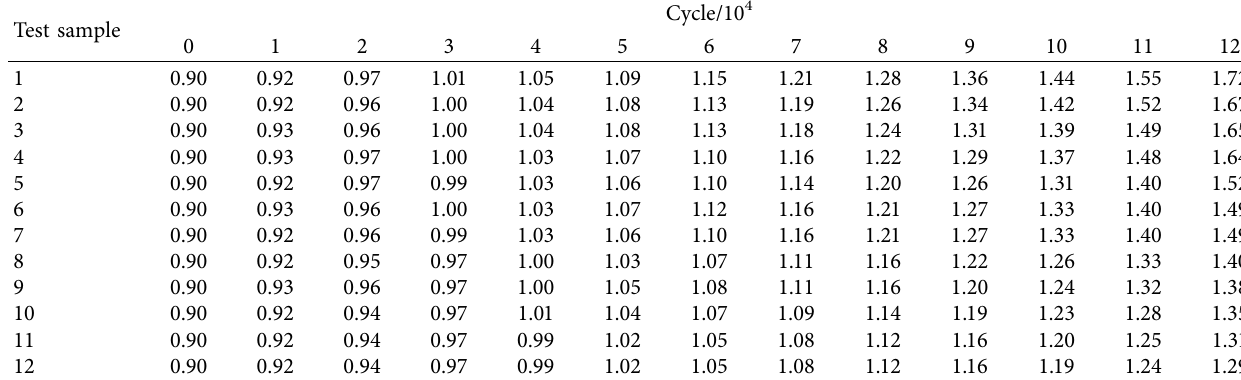
Table 1: Fatigue crack growth data from test samples.